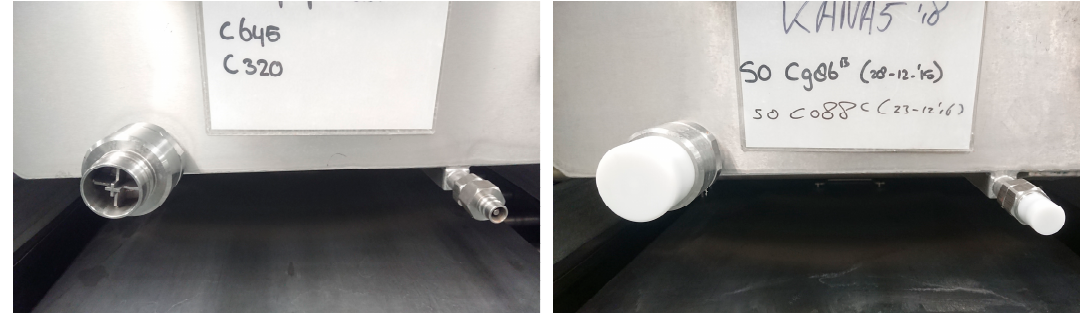
Figure 3. Before ( left panel ) and after ( right panel ) leak prevention of connector of storage tank by placing a cap on the open connector (T-1 in Table 2).